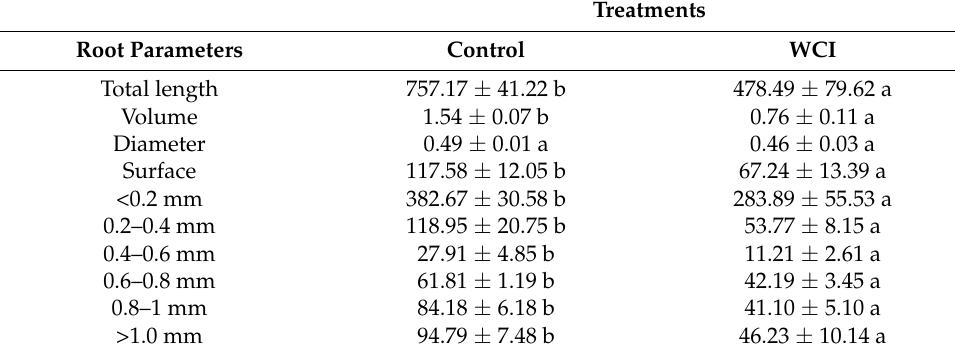
Table 1. The effect of woolly cupgrass on the total root length (cm), root volume (cm 3 ), average root diameter (mm), root surface (cm 2 ), and root length based on root diameter fractions